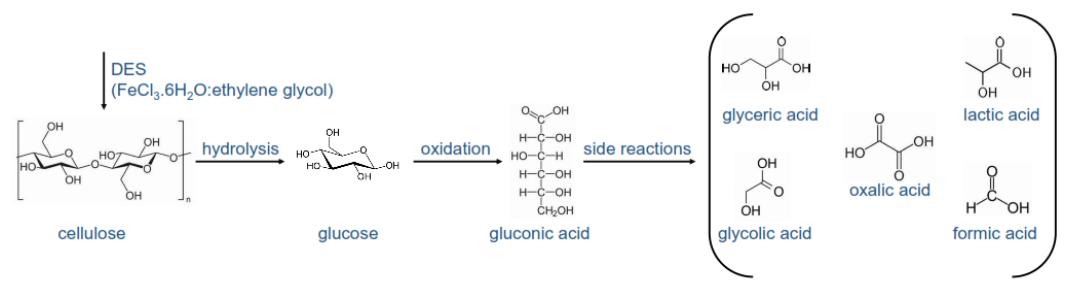
Figure 18. The typical reaction pathway for conversion of cellulosic biomass into value-added chemicals using Lewis acid-type catalytic DESs.